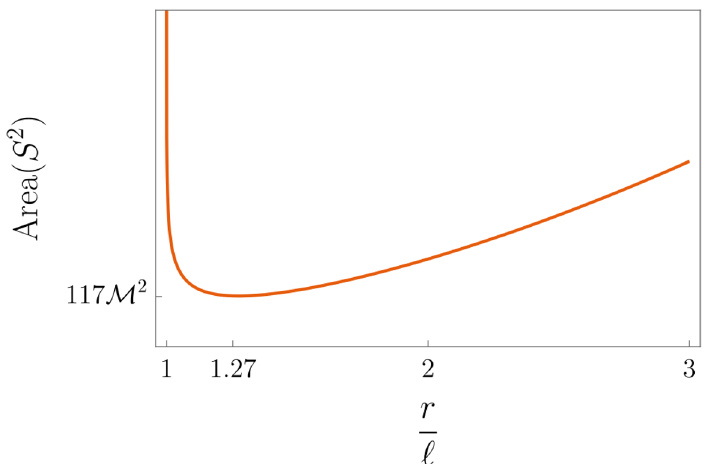
Figure 10 . Area of the S 2 of the bound states of extremal black holes (3.35) for (cid:15) 2 = 2 × 10 − 2